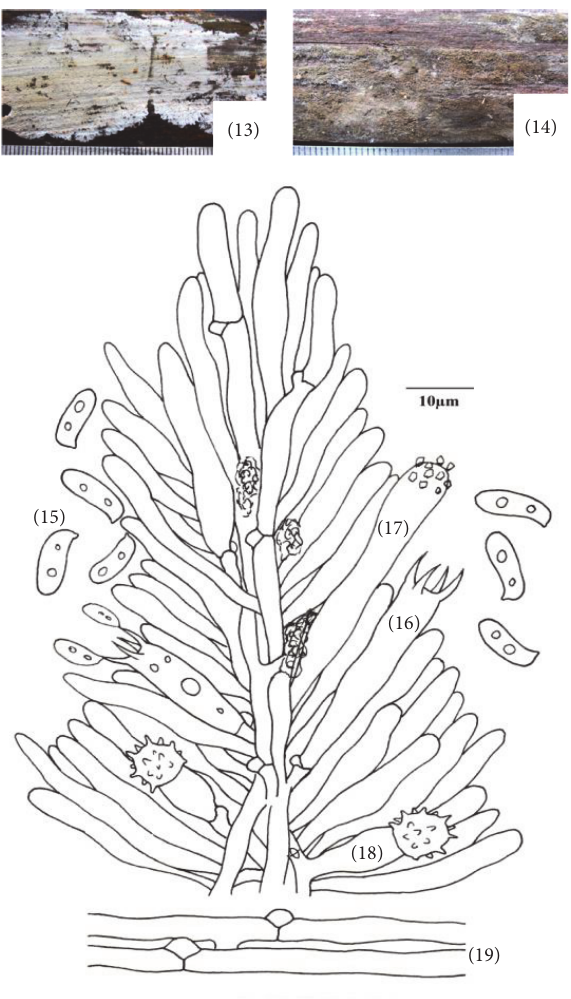
Figure 3: Hyphoderma echinocystis (13)–(19). (13) Fresh basidiocarp, (14) dried basidiocarp, (15) basidiospores, (16) basidium, (17) cystidium, (18) echinocyst, and (19) generative